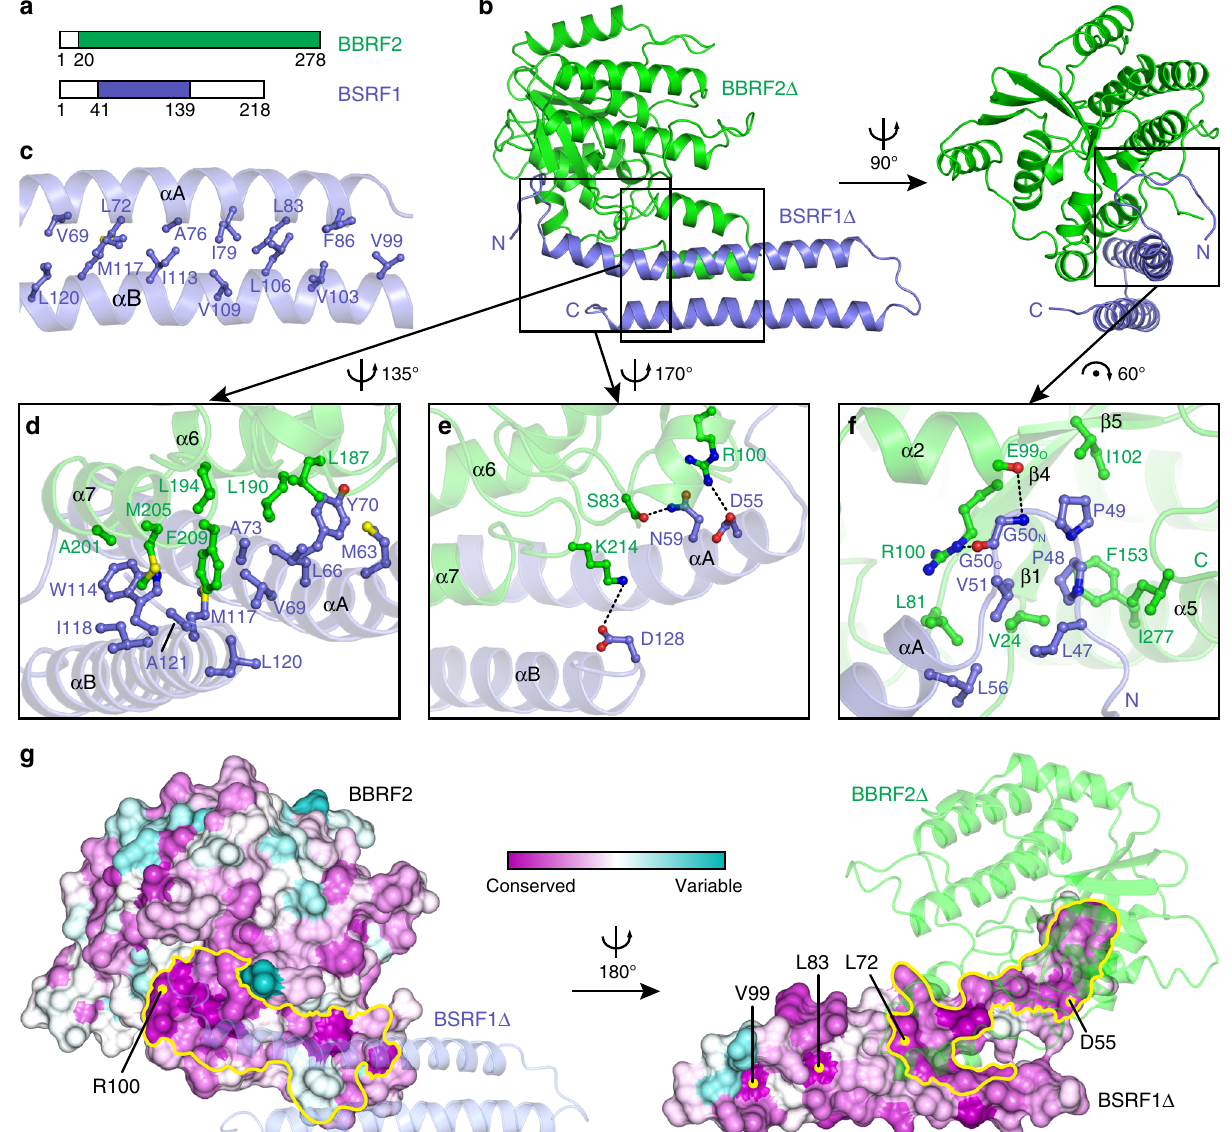
Fig. 3 Details of the BBRF2 Δ -BSRF1 Δ interface. a Schematic showing the discernible residues of BBRF2 Δ and BSRF1 Δ in the BBRF2 Δ -BSRF1 Δ crystal complex (coloured region) compared to full-length BBRF2 and BSRF1. Colour as in Fig. 3b. b Two views of the constitutive heterodimer. Colour as in a . The N- and C-termini of BSRF1 Δ are speci fi ed. c Hydrophobic interactions between the two antiparallel ɑ -helices of BSRF1 Δ . d – f Detailed residue contact at the BBRF2 Δ -BSRF1 Δ interface. The hydrophobic interface ( d ), polar interface ( e ), and BSRF1 Δ N-terminal loop mediated interface ( f ) are shown. Secondary structural elements are labelled. Involved residues are coloured as the molecule to which they belong. g Surface conservation plot of BBRF2 Δ (left) and BSRF1 Δ (right). Associated BSRF1 Δ (left) and BBRF2 Δ (right) are shown with transparency for clarity. The interface of the BBRF2 Δ -BSRF1 Δ heterodimer is outlined in